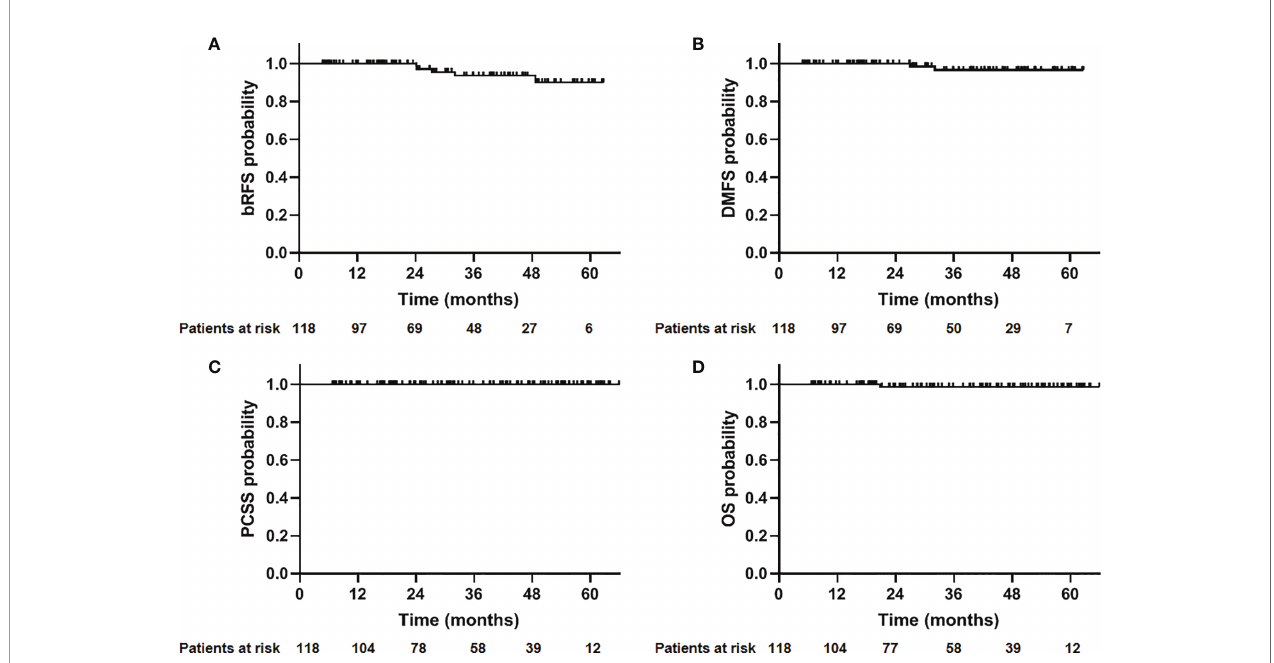
FIGURE 1 | Outcome of 118 patients with prostate cancer treated with CIRT. (A) Biochemical relapse-free survival (bRFS); (B) distant metastasis free survival (DMFS); (C) prostate cancer-speci fi c survival (PCSS); (D) overall survival